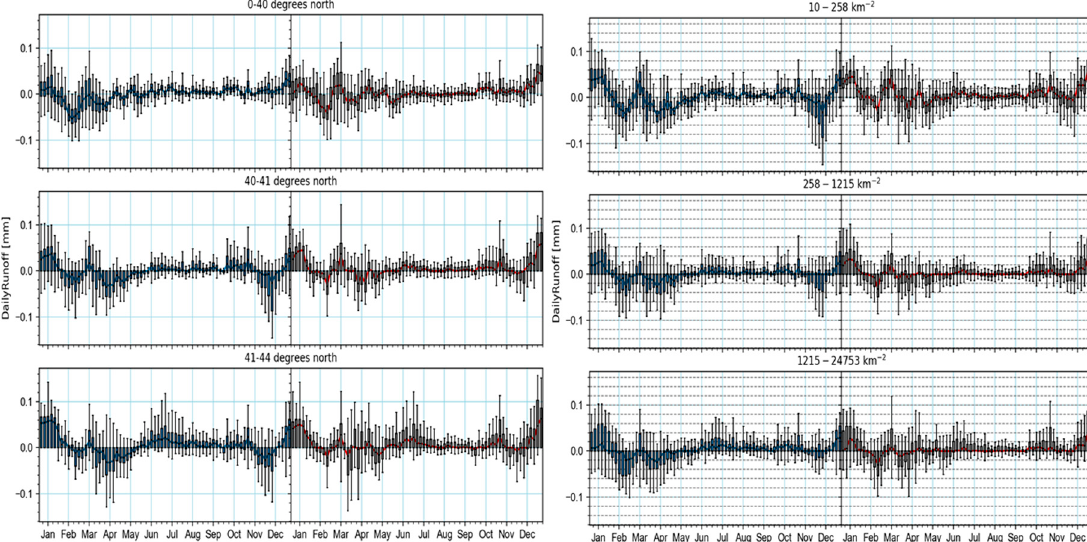
Figure 9. Five-day means (5 dQ ) tendencies by latitude ( left ) and area ( right ) for the model results (blue line) and USGS streamflow Gages II (red).